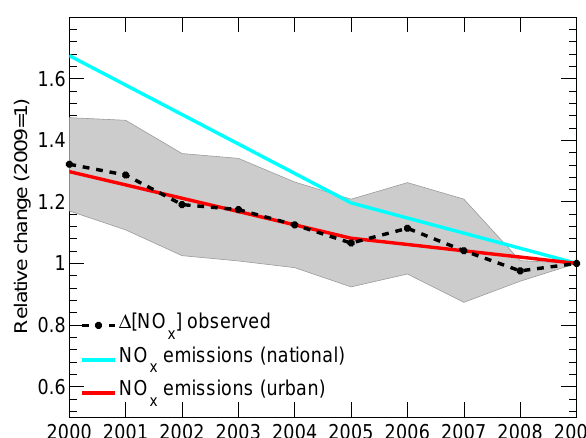
Fig. 7. Trends in observed NO x roadside increments (black), com- pared to calculated emission trends for national average (blue) and urban (red) driving conditions, in Germany. All trends are shown relative to the year 2009. The spread in observations (standard devi- ation of the mean) is indicated as grey shaded area. Note that obser- vations are available for every year, while emissions are calculated only in five-year intervals and interpolated linearly in